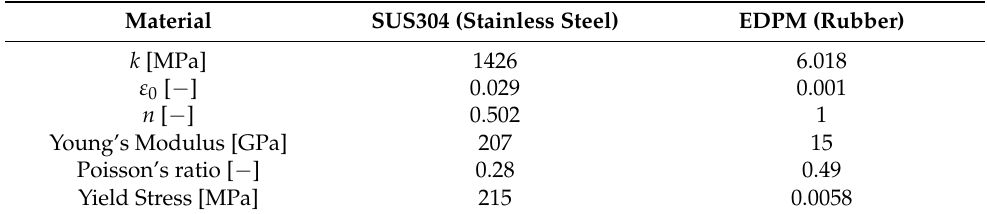
Table 1. Mechanical properties of SUS304 and ethylene propylene diene monomer rubber (EPDM).